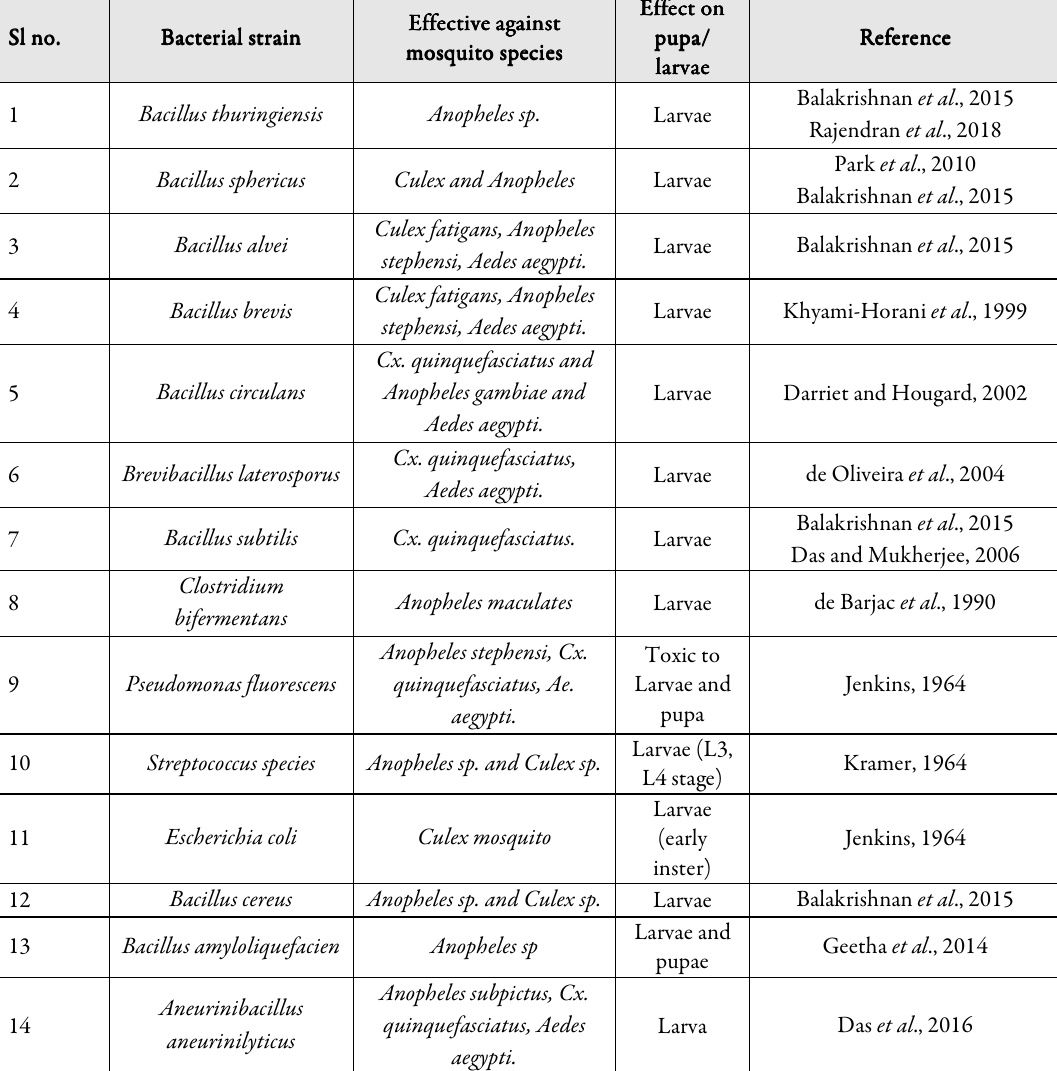
Table 7. List of Bacterial strain reported as a mosquito